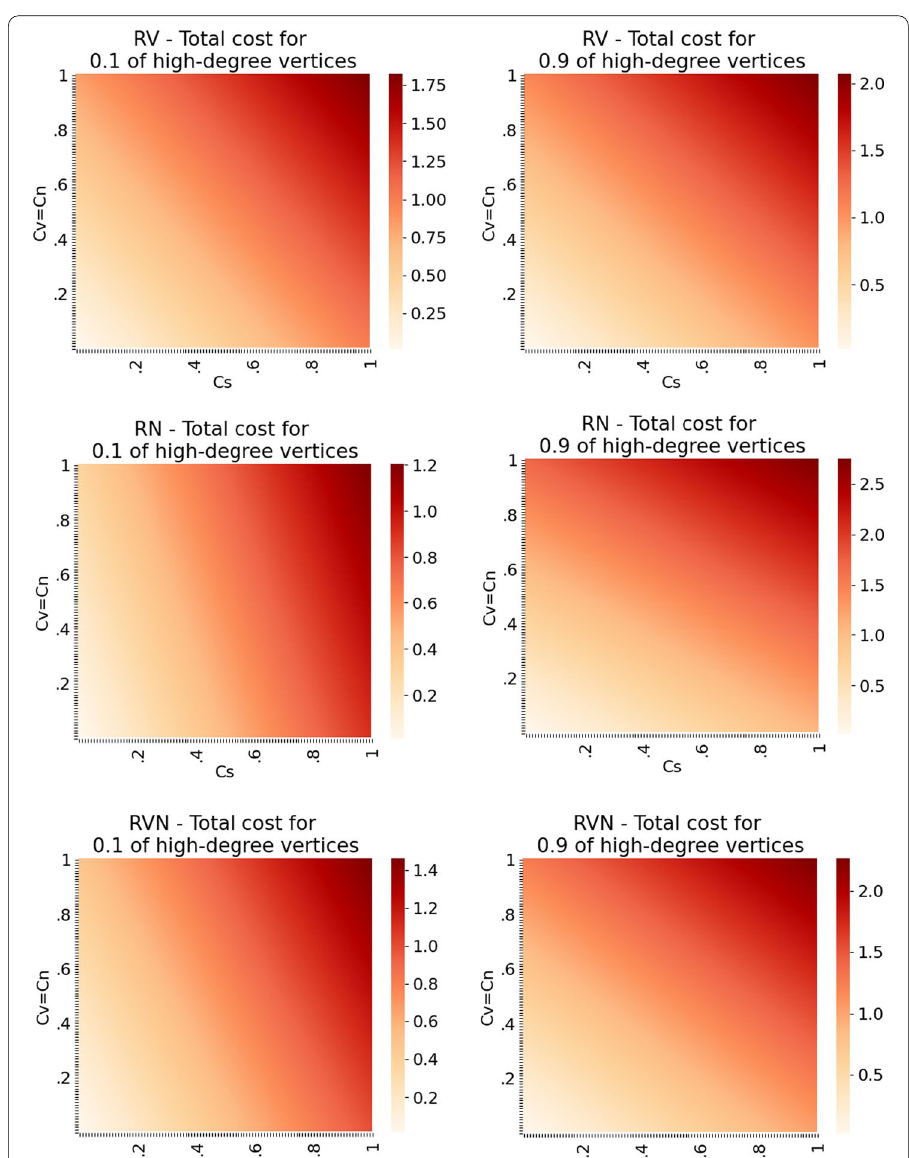
Fig. 7 Heat maps representing effects of sampling ( C v and C n ) and selection ( C s ) costs for the top 10% and 90% of high‑degree